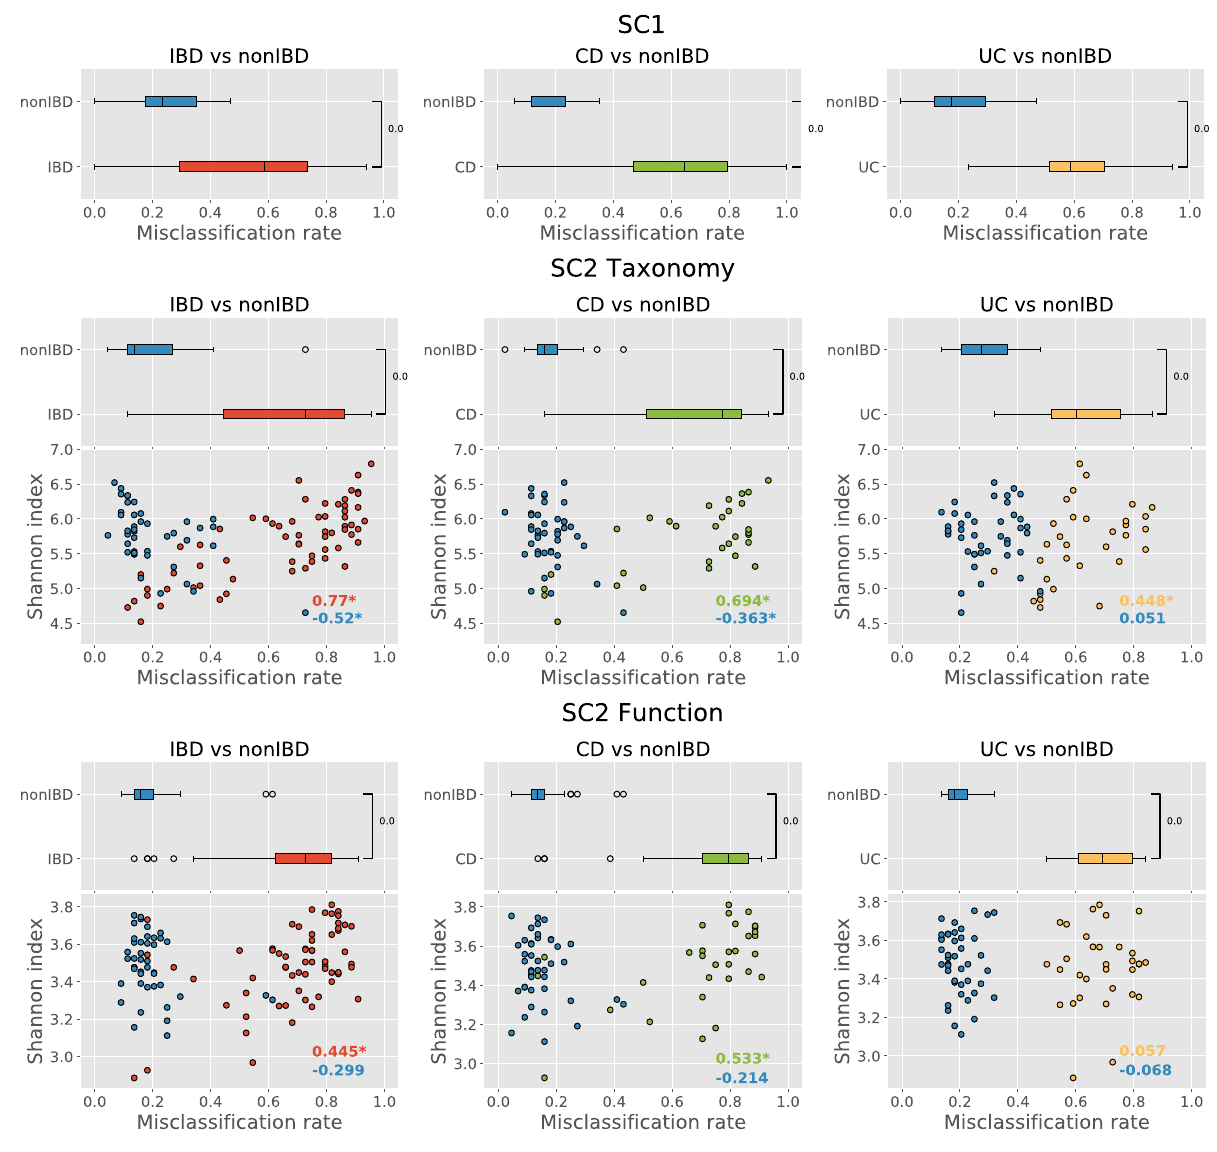
Figure 3. Distribution of sample misclassification rates stratified by group. Results for different SC, data types (for SC2), and 2-class tasks are shown separately. Results for SC2 also have additional panels representing the correlation between samples’ misclassification rate and diversity. Samples are stratified by group. Correlation coefficients between misclassification rate and diversity are shown on the lower right corner of each SC2-related plots. *next to the correlation coefficient implies P value <